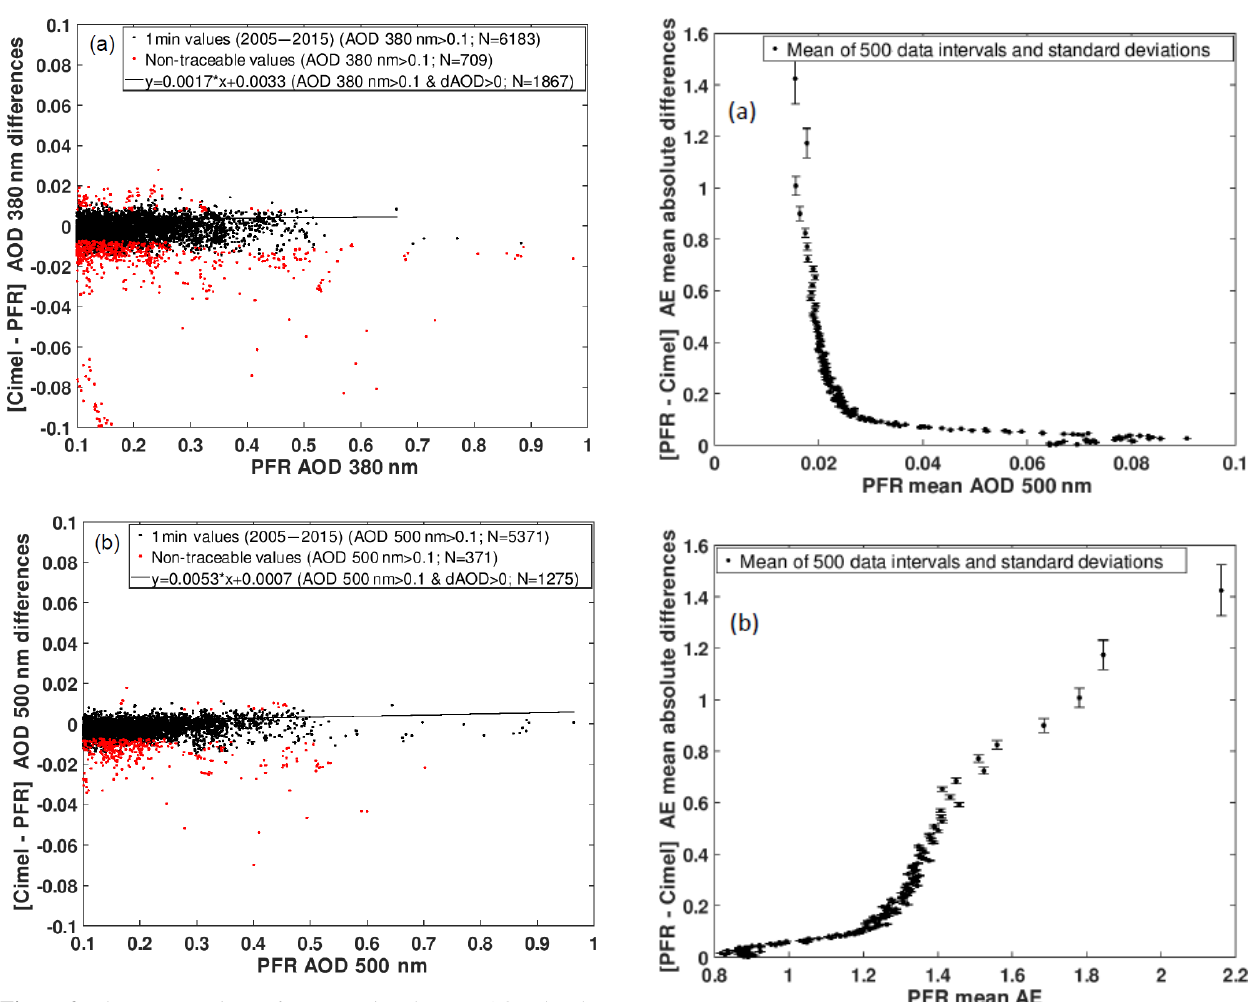
Figure 9. The same as Fig. 7 after correcting the PFR AOD data by adding + 3 . 3% at 380nm and + 2 . 2% at 500nm to the 1min PFR AOD data > 0 . 1.